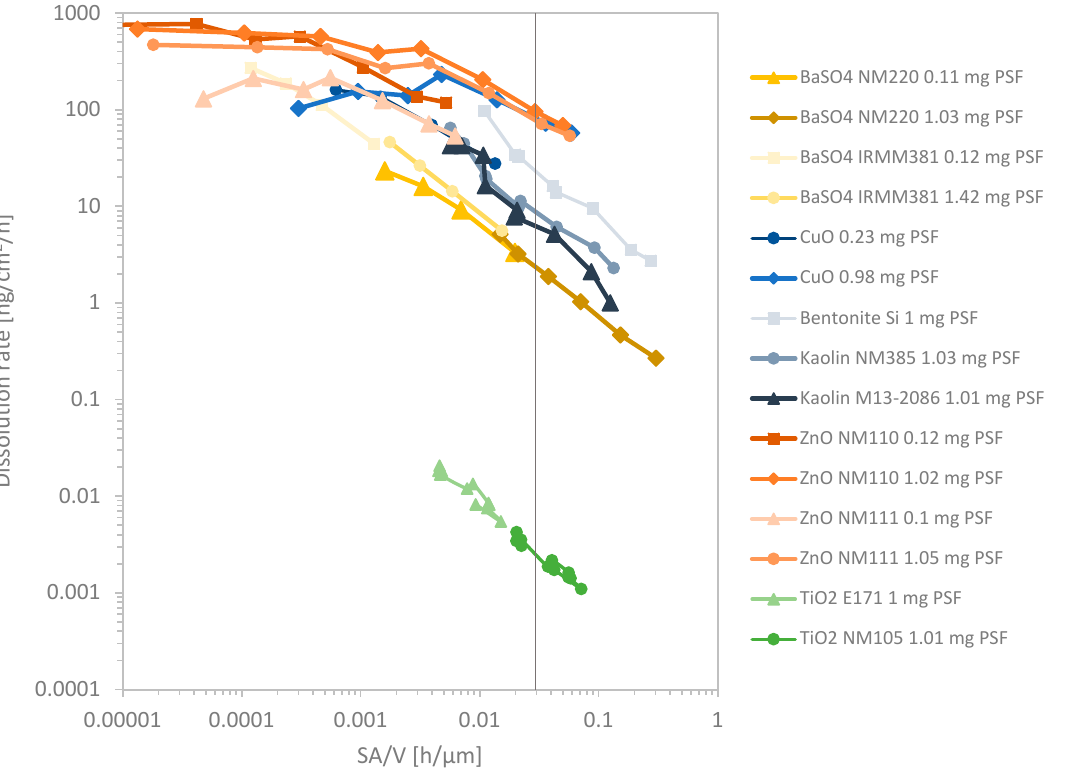
Figure 5. Cumulated SA/V plot vs. dissolution rate k [ng/cm²/h] of 10 different tested nanomaterials in 15 different runs with varying initial masses. The dots of each run are connected through a line with each other for visualization purpose only. The family of TiO 2 (nano)forms is displayed in green, BaSO 4 (nano)forms in yellow, CuO in blue, ZnO in shades of orange, and aluminosilicates Bentonite and Kaolin in grey. The vertical line displays the optimum SA/V.